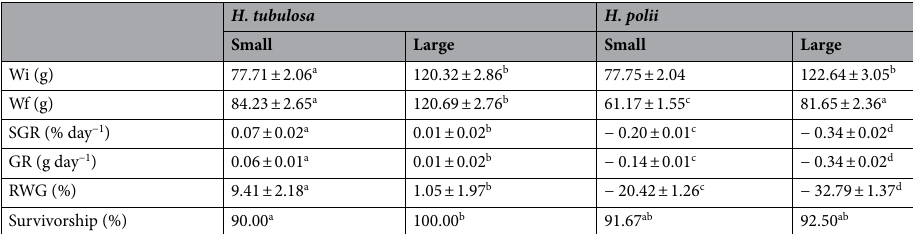
Table 1. Biometric measurements, growth performances and survival rates of small and large specimens of Holothuria tubulosa and Holothuria polii reared below an off-shore mussel farm over the four-month experiment. Wi initial wet weight (g), Wf final wet weight (g), SGR (% day −1 ) Somatic Growth Rate; GR (g day −1 ) growth rate, RWG (%) relative weight gain (Means ± SE). The different letters indicate significant differences ( p < 0.05) among the experimental diets (two-way ANOVA followed by Tukey’s test for comparisons of Wi, Wf, SGR and RWG; Chi-squared test for comparisons of survivorship).